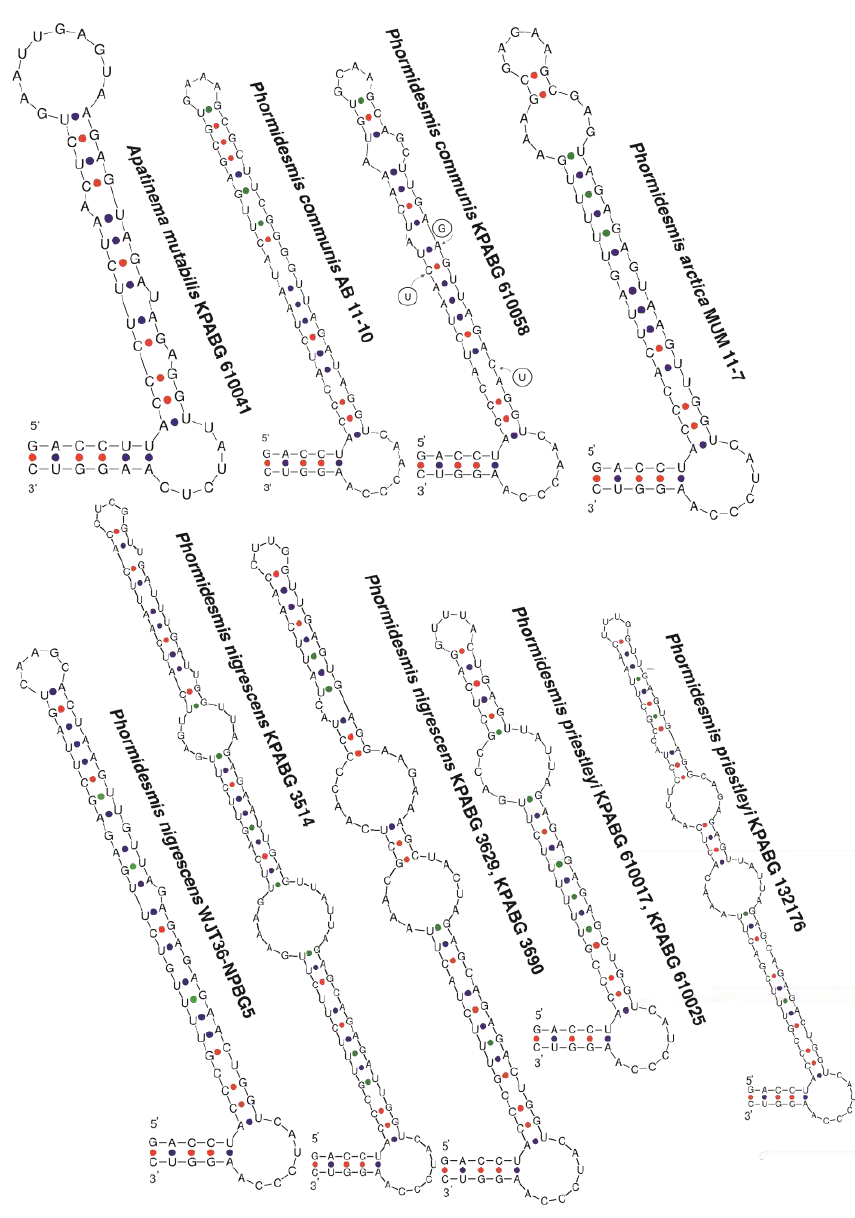
Figure 4. Secondary structure of the D1- D1’ helix of the 16S– 23S ITS region.